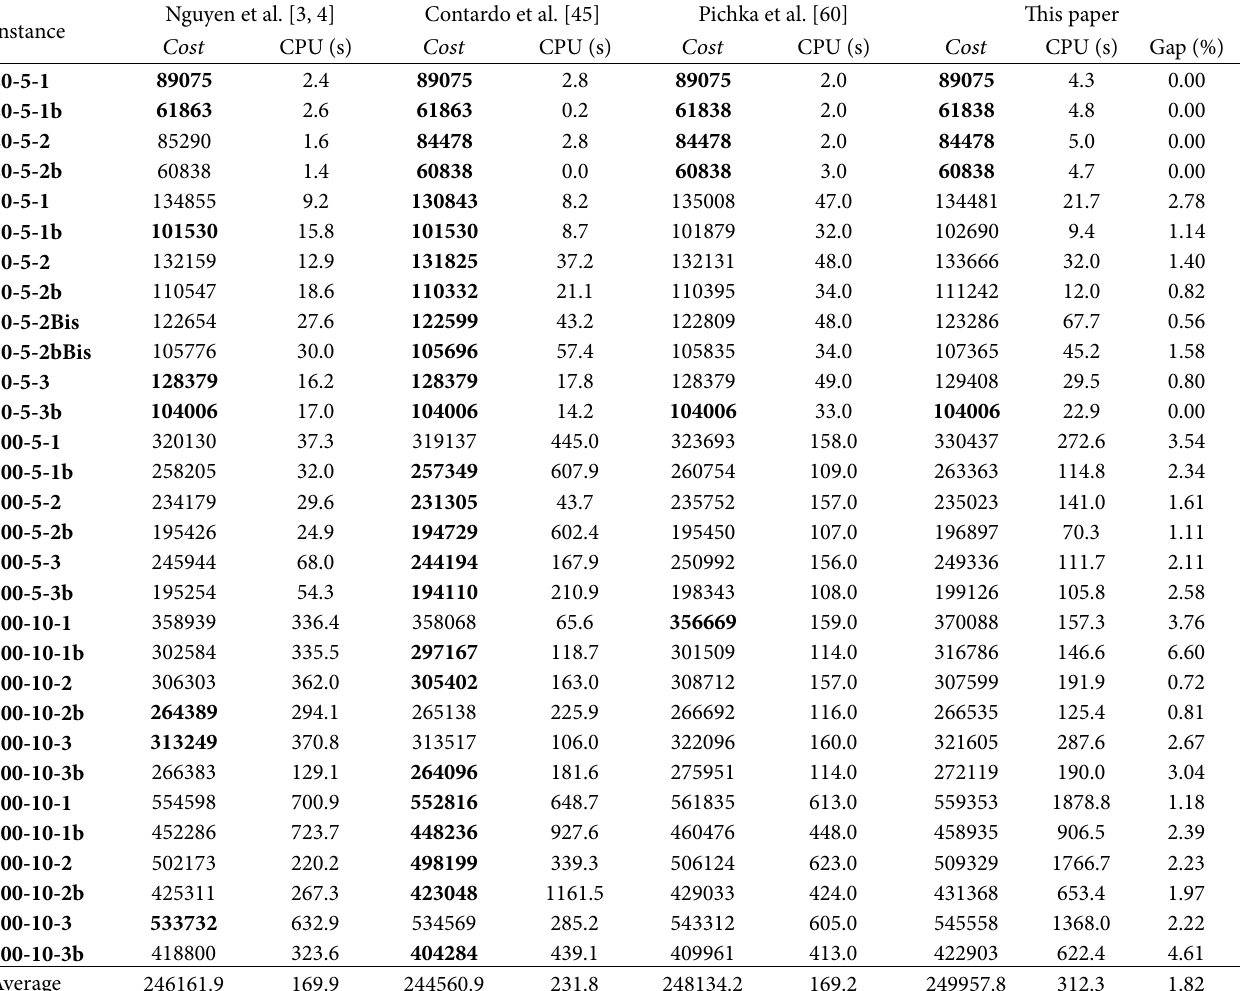
Table 3: Comparison of MHH-PR and other heuristics in Prodhon’s 2E-LRP instances